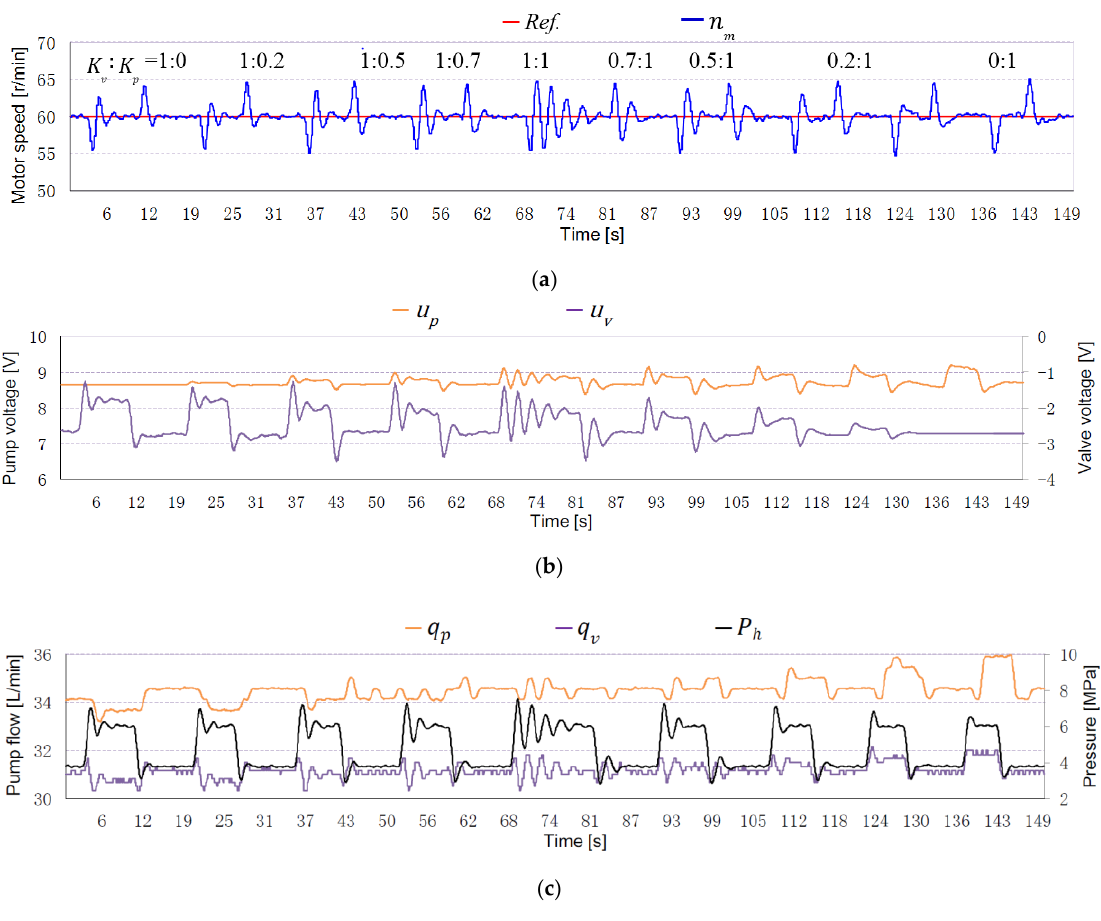
Figure 9. Step response to loads under different weight ratios K vp . ( a ) Motor speed response; ( b ) Pump and valve voltage variation; ( c ) System pressure and flow response.